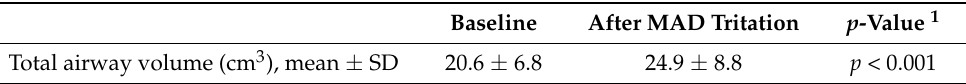
Table 3. Changes in total airway volume before and after treatment with the mandibular advancement device (MAD).